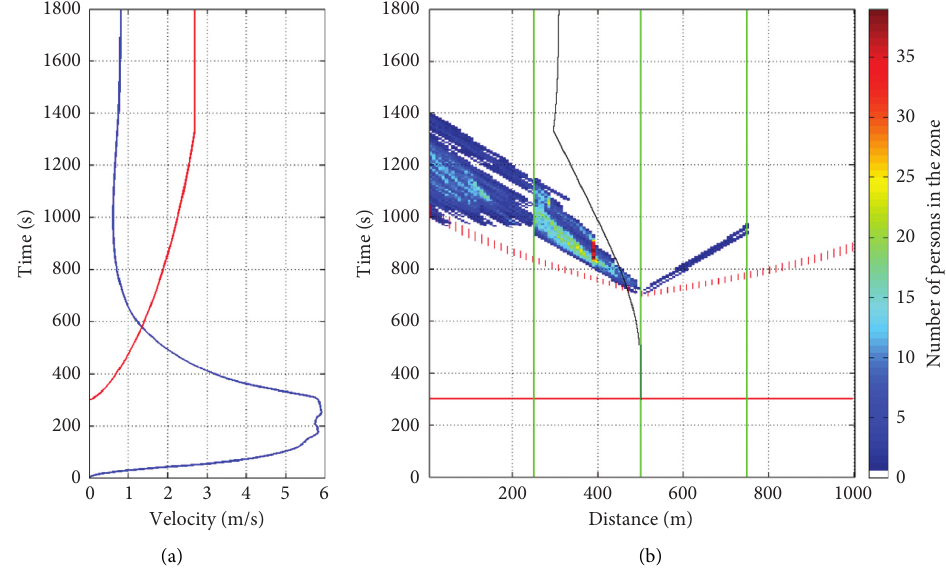
Figure 16: Course of evacuation for the truck fire with switched-off ventilation. (a) Velocity of air flow. (b) Course of evaluation.